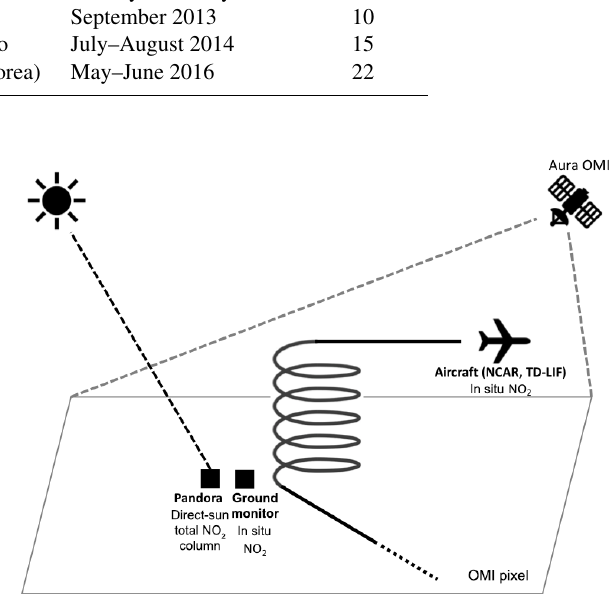
Figure 1. Conceptual illustration of NO 2 observations during the DISCOVER-AQ and KORUS-AQ field campaigns. The instruments used include ground-based monitors measuring in situ NO 2 volume mixing ratios, Pandora making direct-sun measurements to retrieve the total column NO 2 , airborne instruments measuring in situ NO 2 profiles, and the Ozone Monitoring Instrument (OMI) aboard the Aura spacecraft reporting total column and tropospheric column NO 2